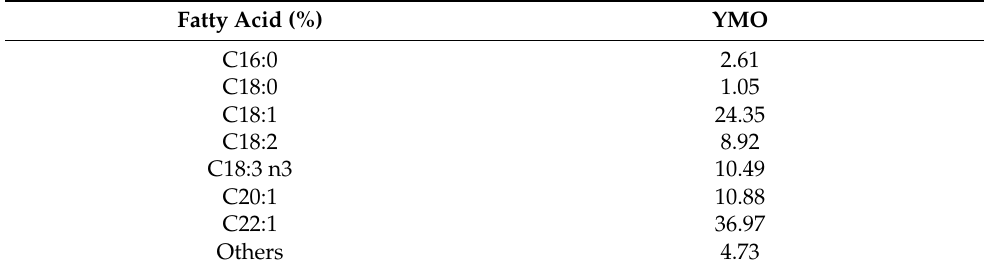
Table 1. Composition of fatty acids in